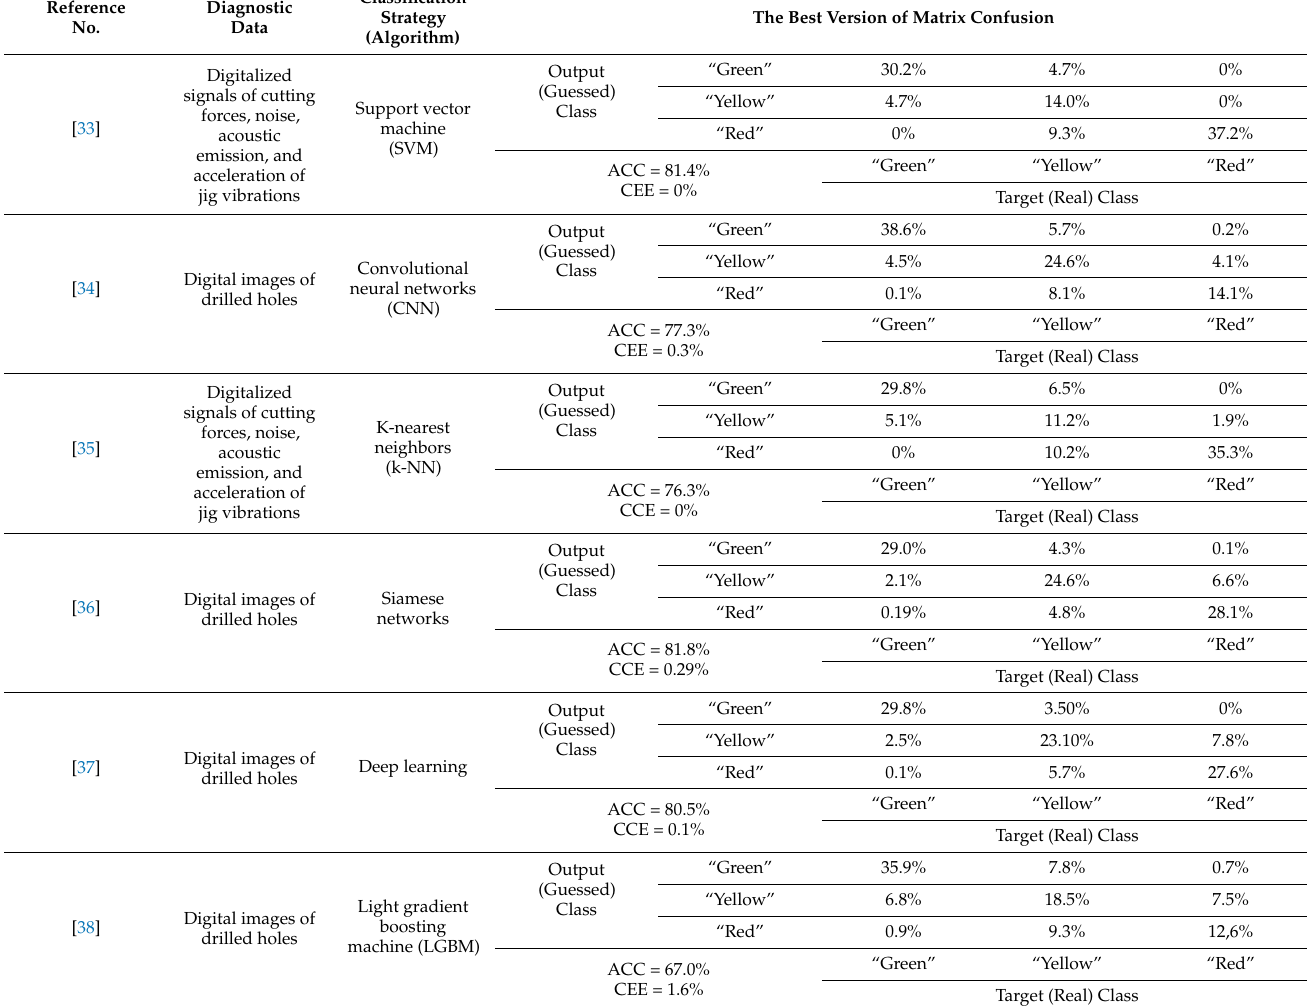
Table 2. Confusion matrices that have been achieved in the five different studies belonging to the new research trend in drill condition monitoring